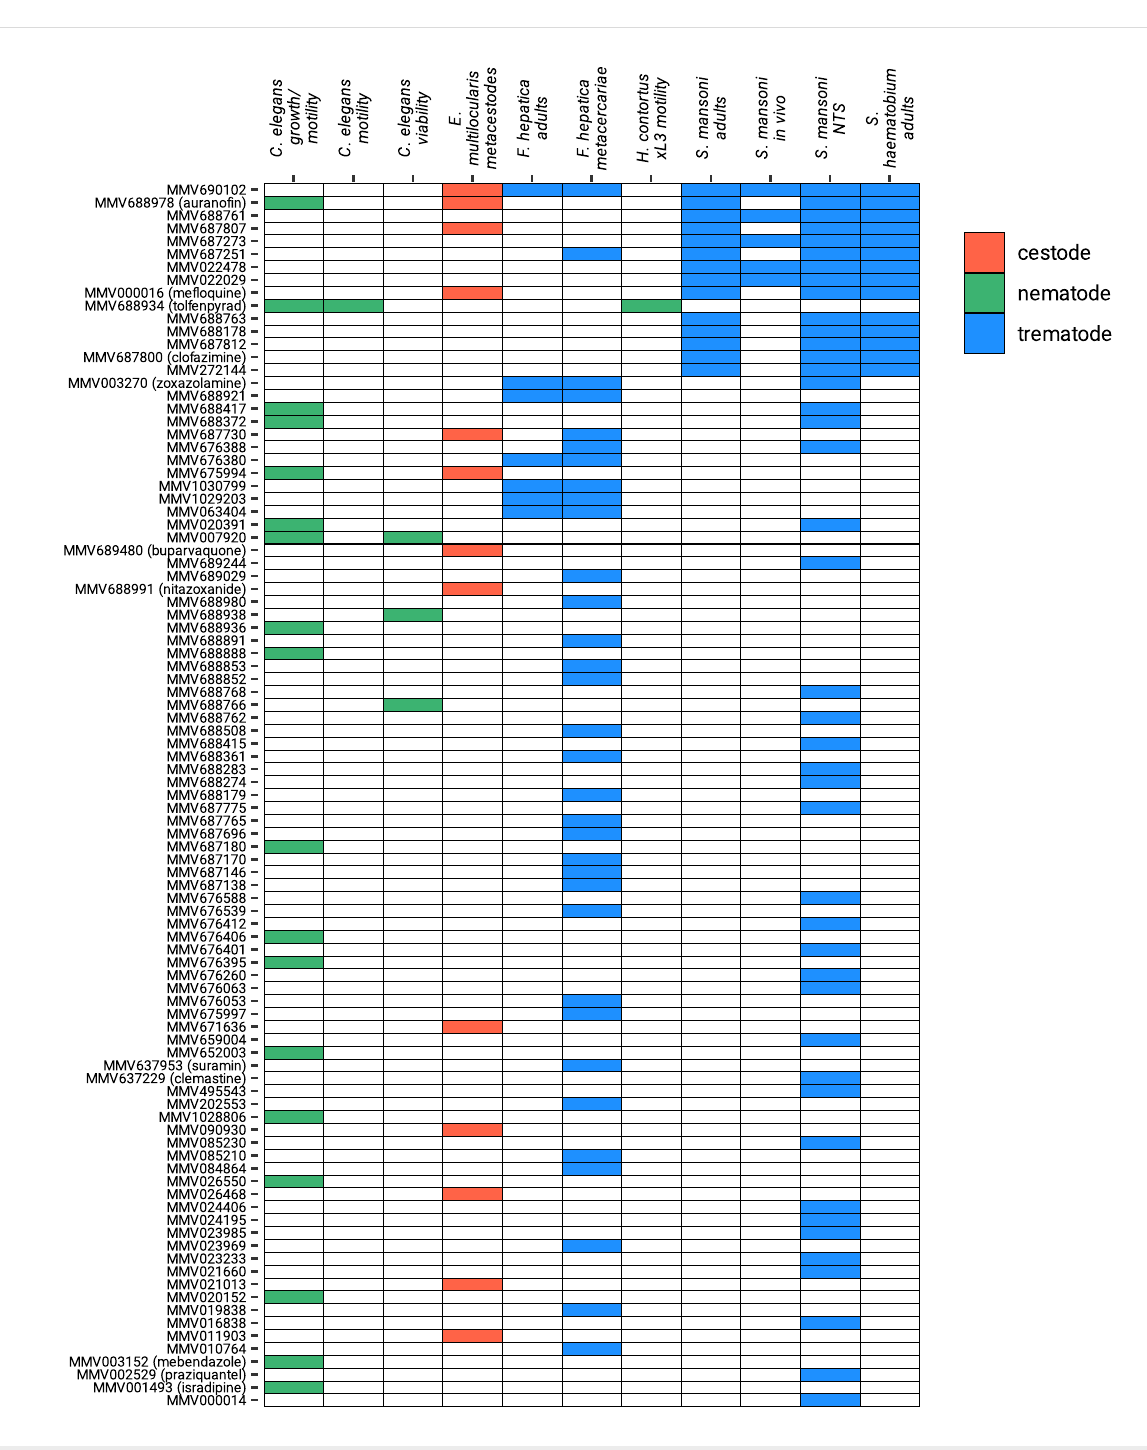
Figure 5: Active compounds from anthelmintic screens using the MMV Pathogen Box. NTS: newly transformed schistosomula, xL3: exsheathed L3. Assay outline and citations for data sources: C. elegans growth/motility screen – automated quantification using the INVAPP system [135]. C. elegans motility screen – automated quantification using the WMicrotracker ONE system [163]. C. elegans viability screen – automated quantification of viability by differential absorption of the dyes DB-1 and propidium iodide [164]. E. multilocularis metacestode screen – damage was assessed by quantifying the activity of phosphoglucose isomerase released into the culture media [162]. F. hepatica screens – viability of metacercariae was assessed using a scoring system taking into account membrane damage and fluke translucency, and viability of adults was assessed using a scoring system taking into account worm motility, colour and rigidity [165]. H. contortus screen – automated quantification of motility of exsheathed L3 worms [129], S. haematobium and S. mansoni screens – activity was assessed using a scoring system taking into account motility and morphological/tegu- mental changes